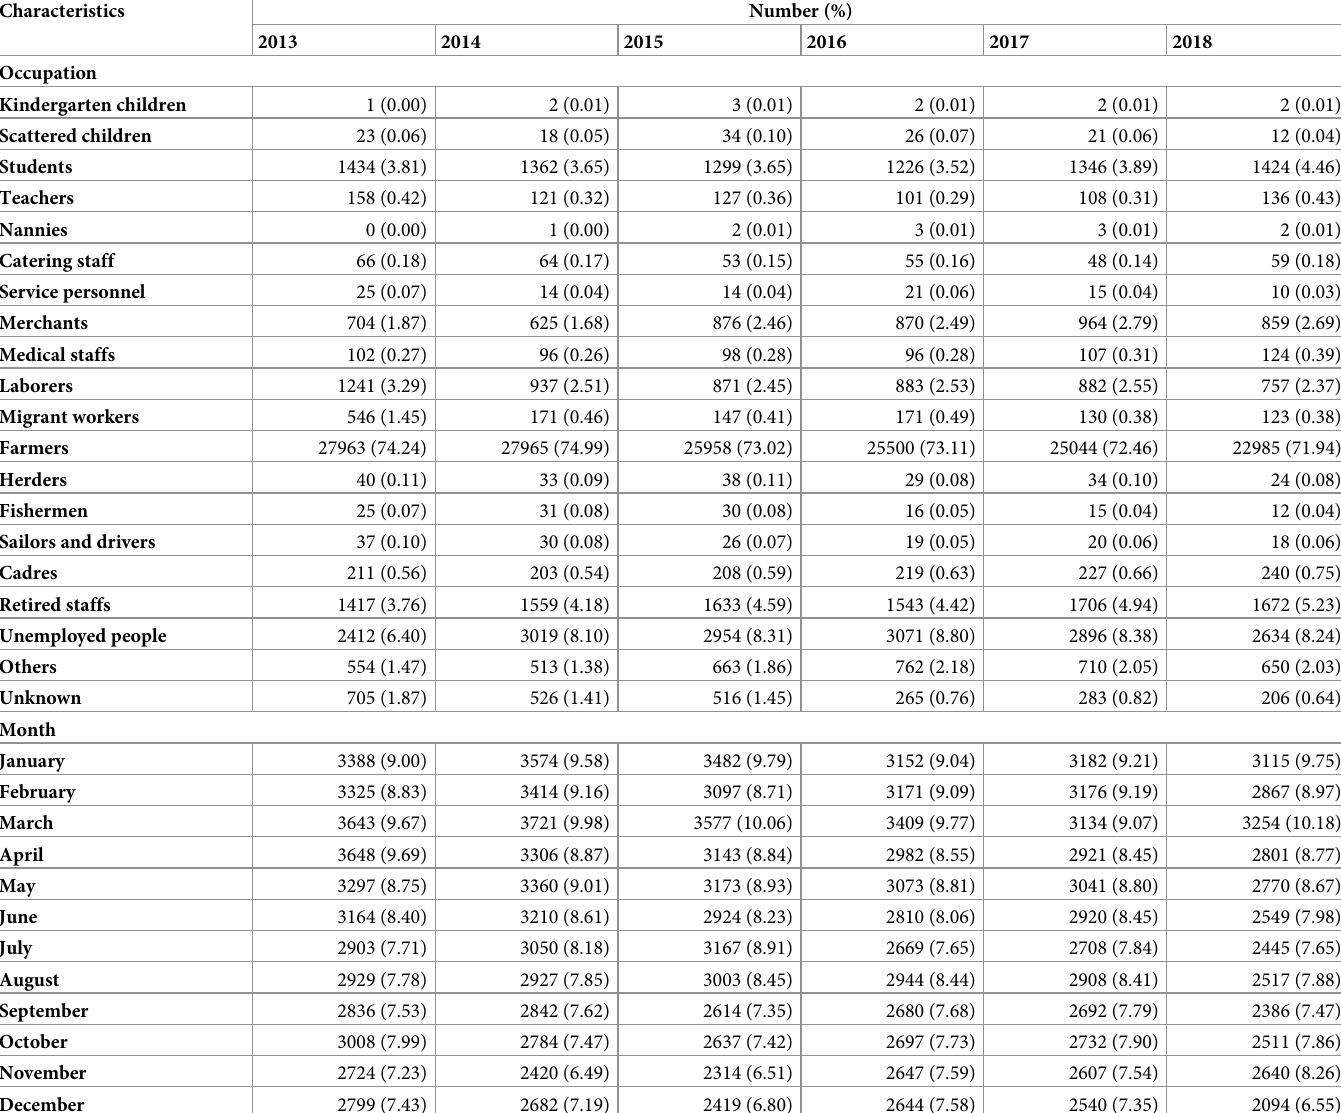
Table 1. Patient occupations and monthly distributions of reported pulmonary tuberculosis cases in Anhui province, Eastern China,